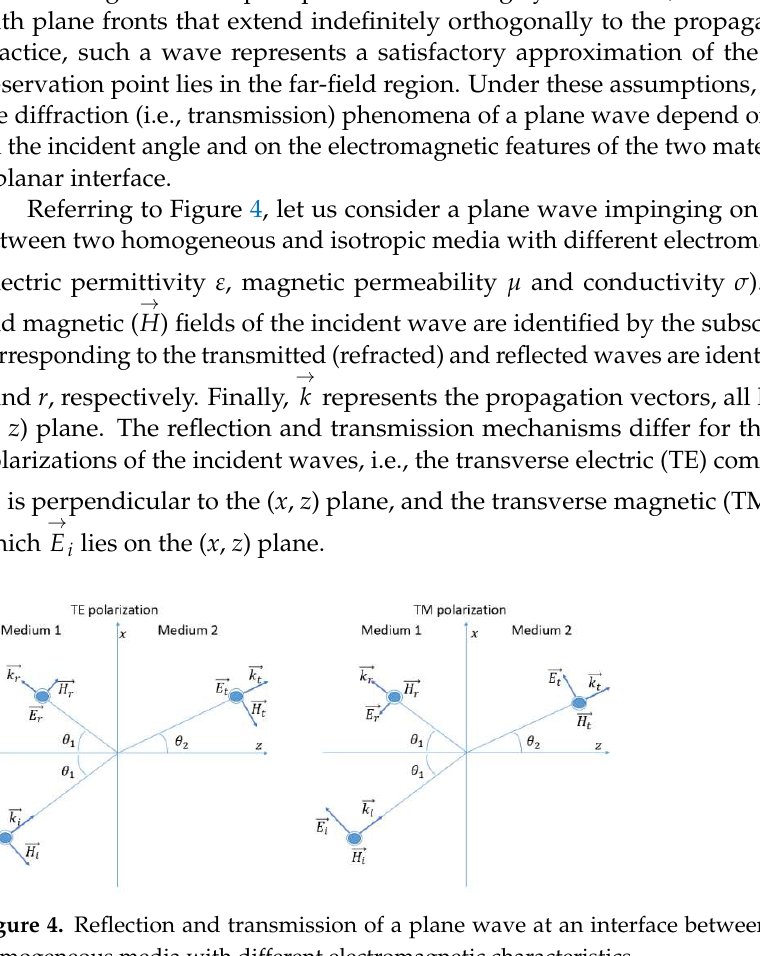
Figure 3. CDFs of the building height (Hb1) for London and Melbourne, extracted from [11].